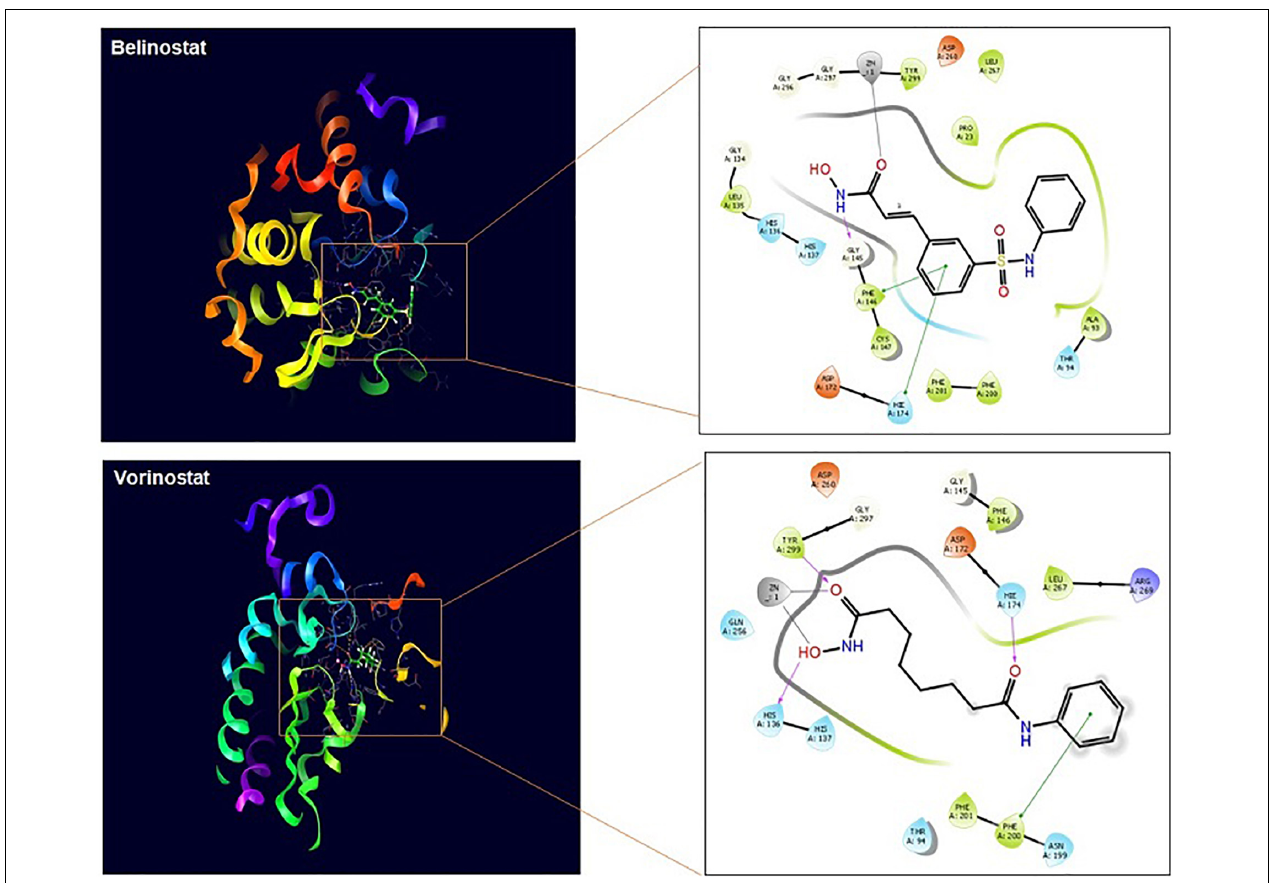
FIGURE 5 | TaHDAC1 homology model structure with docked ligands. The first figure shows the secondary structure representation of the homology model of TaHDAC1. The second part of the figure shows the 2D interaction between the inhibitor and the modeled protein amino acid residue. The docking poses are shown for ligands (vorinostat) and (belinostat) in TaHDAC1 . Critical interactions with zinc atom (gray line), π − π interactions (green line), and hydrogen bonds (pink line) are